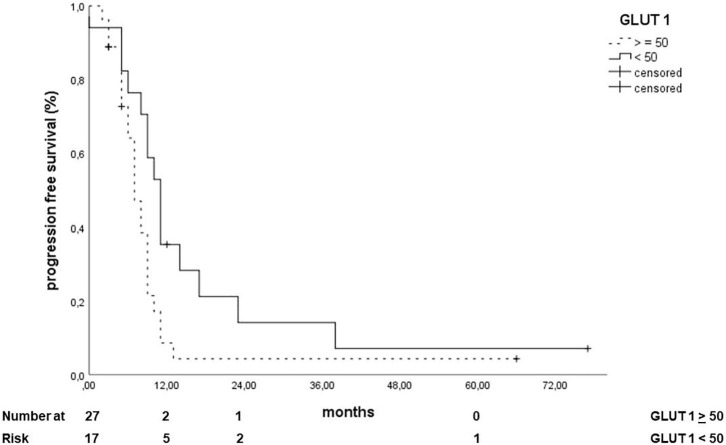
Correlation of GLUT 1 expression (over the median) with progression-free survival.